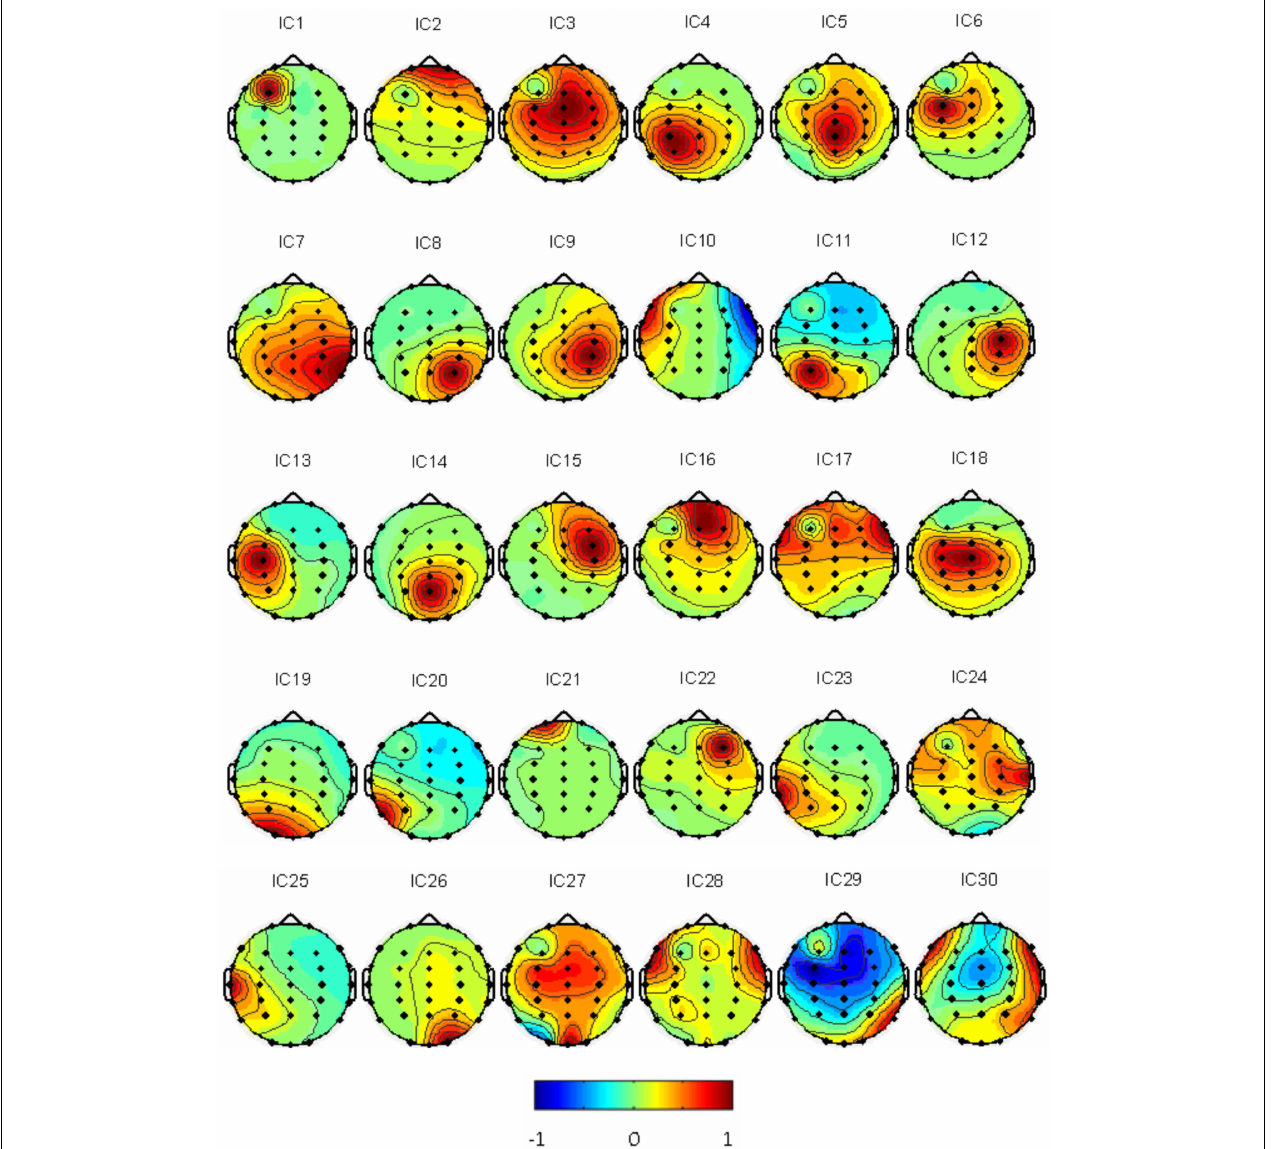
FIGURE 1 | Thirty IC spatial distributions in a representative subject (blue represents –1, red represents 1).